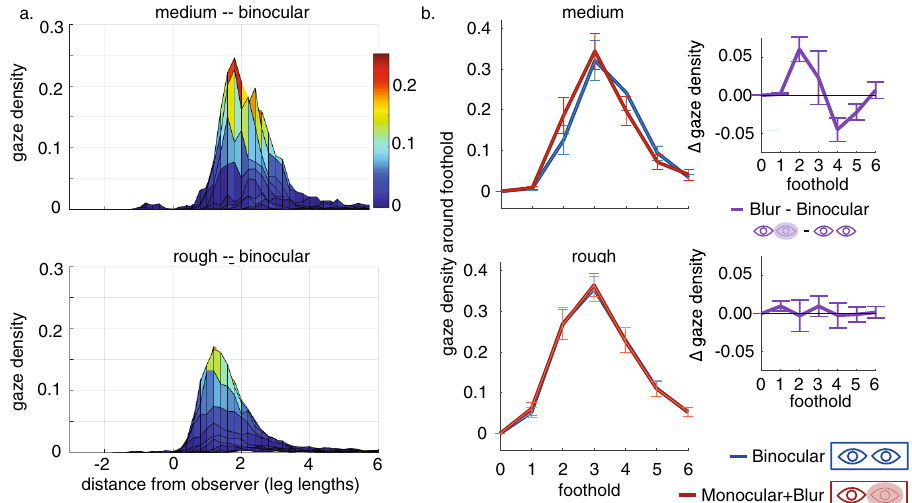
Figure 3. An analysis of gaze densities demonstrates a bias in gaze toward the body for participants during the blur condition in the medium terrain. ( a ) The average gaze distribution relative to the planted foot in the binocular condition for the medium (top) and rough (bottom) terrains. This distribution is two-dimensional, though here it is viewed from a single angle that allows us to view the distribution along the path, i.e., the x-axis here corresponds to the participant’s current walking direction so that the positive direction is down the path in front of the observer. The relationship between these distributions and the summary statistics shown in b, are described in the “Methods” section and follow the methodology depicted in Fig. 6. ( b ) The two panels on the left show gaze density around footholds 1–6 footholds ahead, derived as described in the “Methods” section, for medium (top) and rough terrains (bottom). Note that the rough terrain shows a greater allocation of gaze to nearer footholds (specifically 2 footholds ahead). The blue and red curves show the binocular and blur conditions for the 8 normal participants. The panels on the right show the within participants differences (purple) between the binocular and blur conditions. Error bars are ± 1